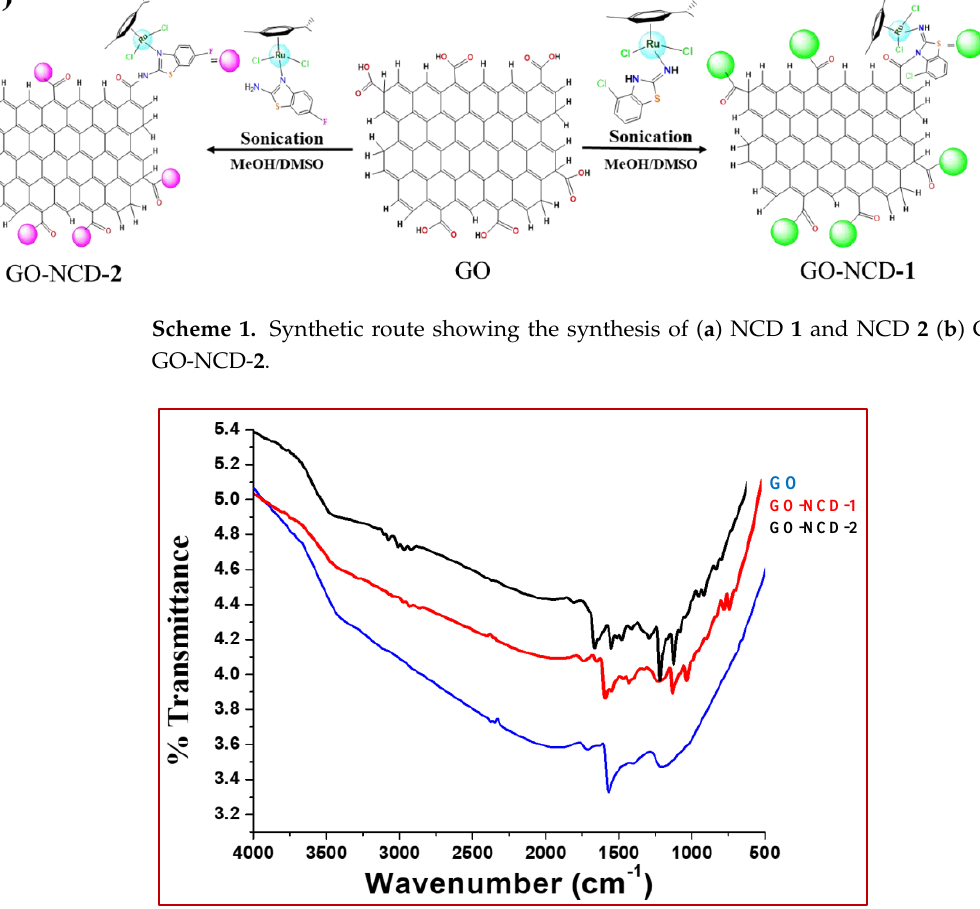
Figure 2. TGA of ( a ) GO-NCD- 1 ( b ) GO-NCD- 2, and ( c ) GO. The XRD spectra were measured in the range of 5 to 80°. In the case of GO, peaks were observed at 2 θ = 11.11°, 26.59°, 13.9°, and 10.54°, whereas GO-NCD- 1 showed peaks at 13.82°, 15.46°, 16.81°, and 26.4°. For GO-NCD-2, peaks were observed at 10.84°, 13.56°, 15.04°, 16.04°, 22.37°, 26.59°, and 38.95°. The peaks at 11.11° were assigned to the oxygenic functional groups and trapped water molecules of the graphene oxide. The broadening of the peaks of NCD 1 and NCD 2 were observed after their loading on graphene oxide, which could be due to the decrease in size from bulk to nanoscale dimensions (Figures 3, S4 and S5). The broadening of the peaks around 26.59° suggested the functionalization of the major oxygen containing groups of the GO, therefore confirming the successful binding of both drug candidates on the nanodrug carrier [28 – 30].